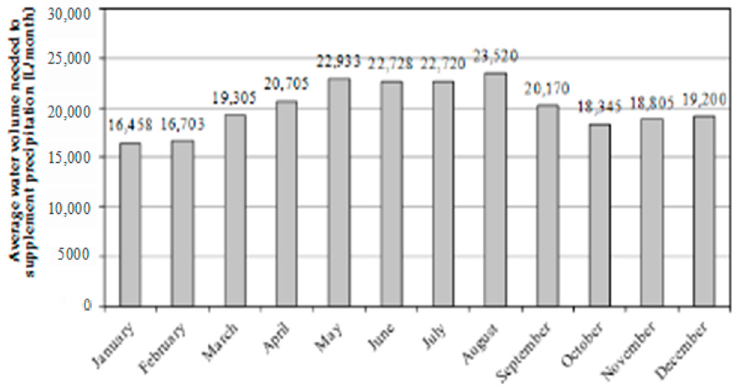
Figure 9. Monthly volume of water needed to complement